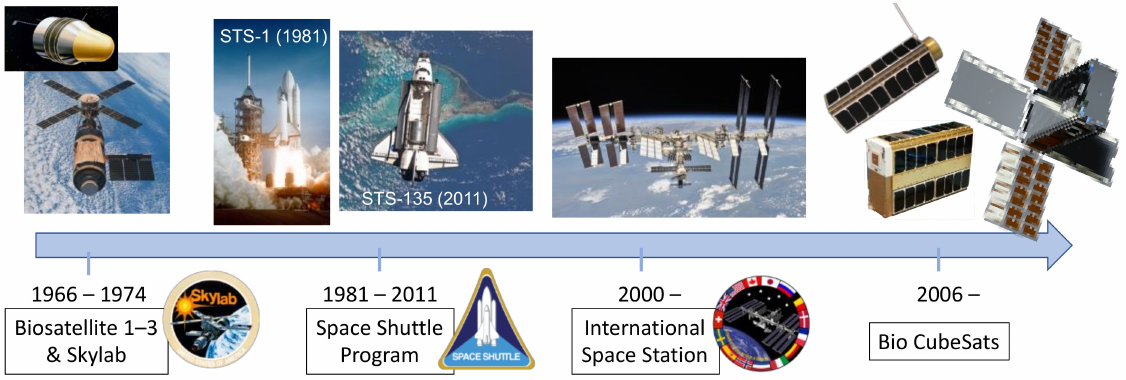
Figure 1. NASA’s life science